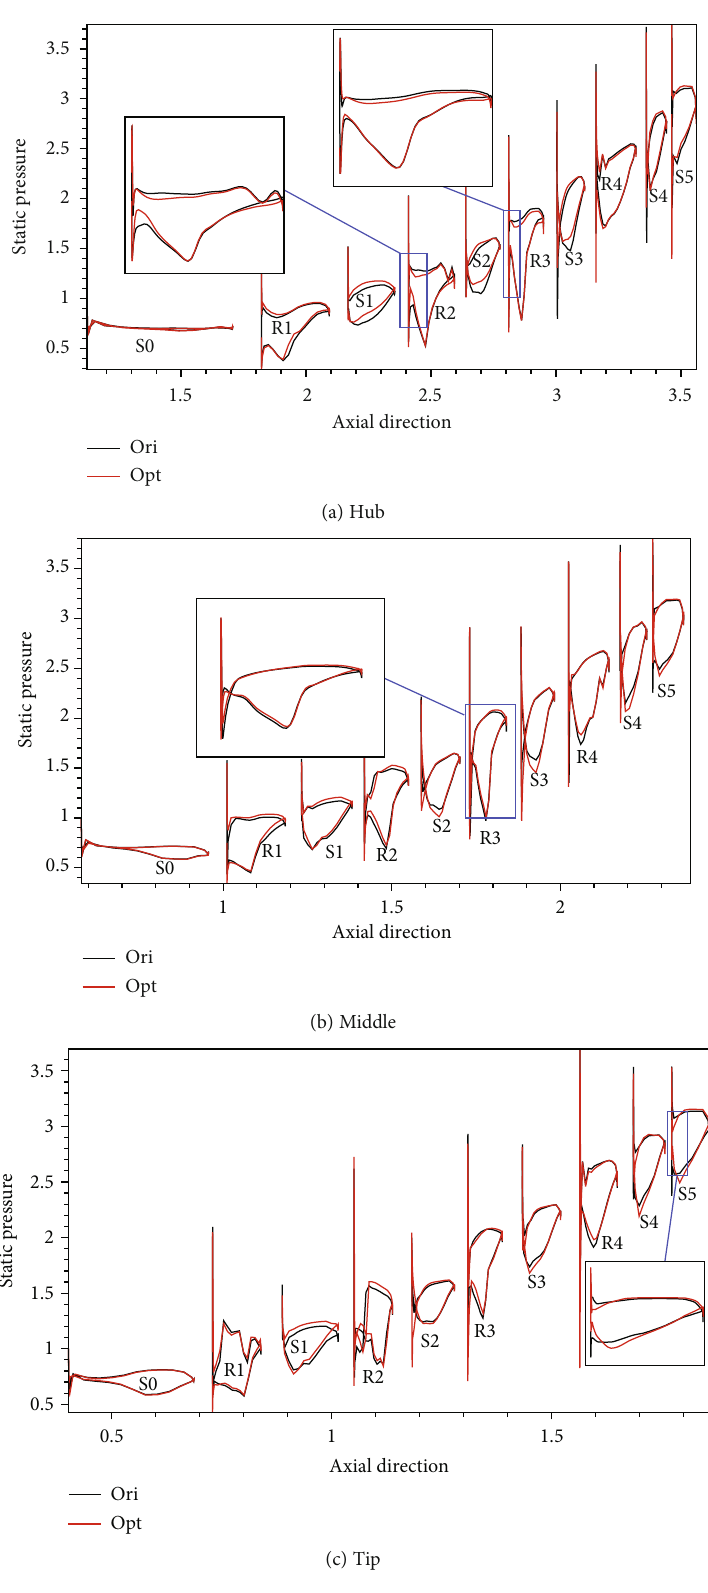
Figure 16: Comparison of the static pressure distribution before and after